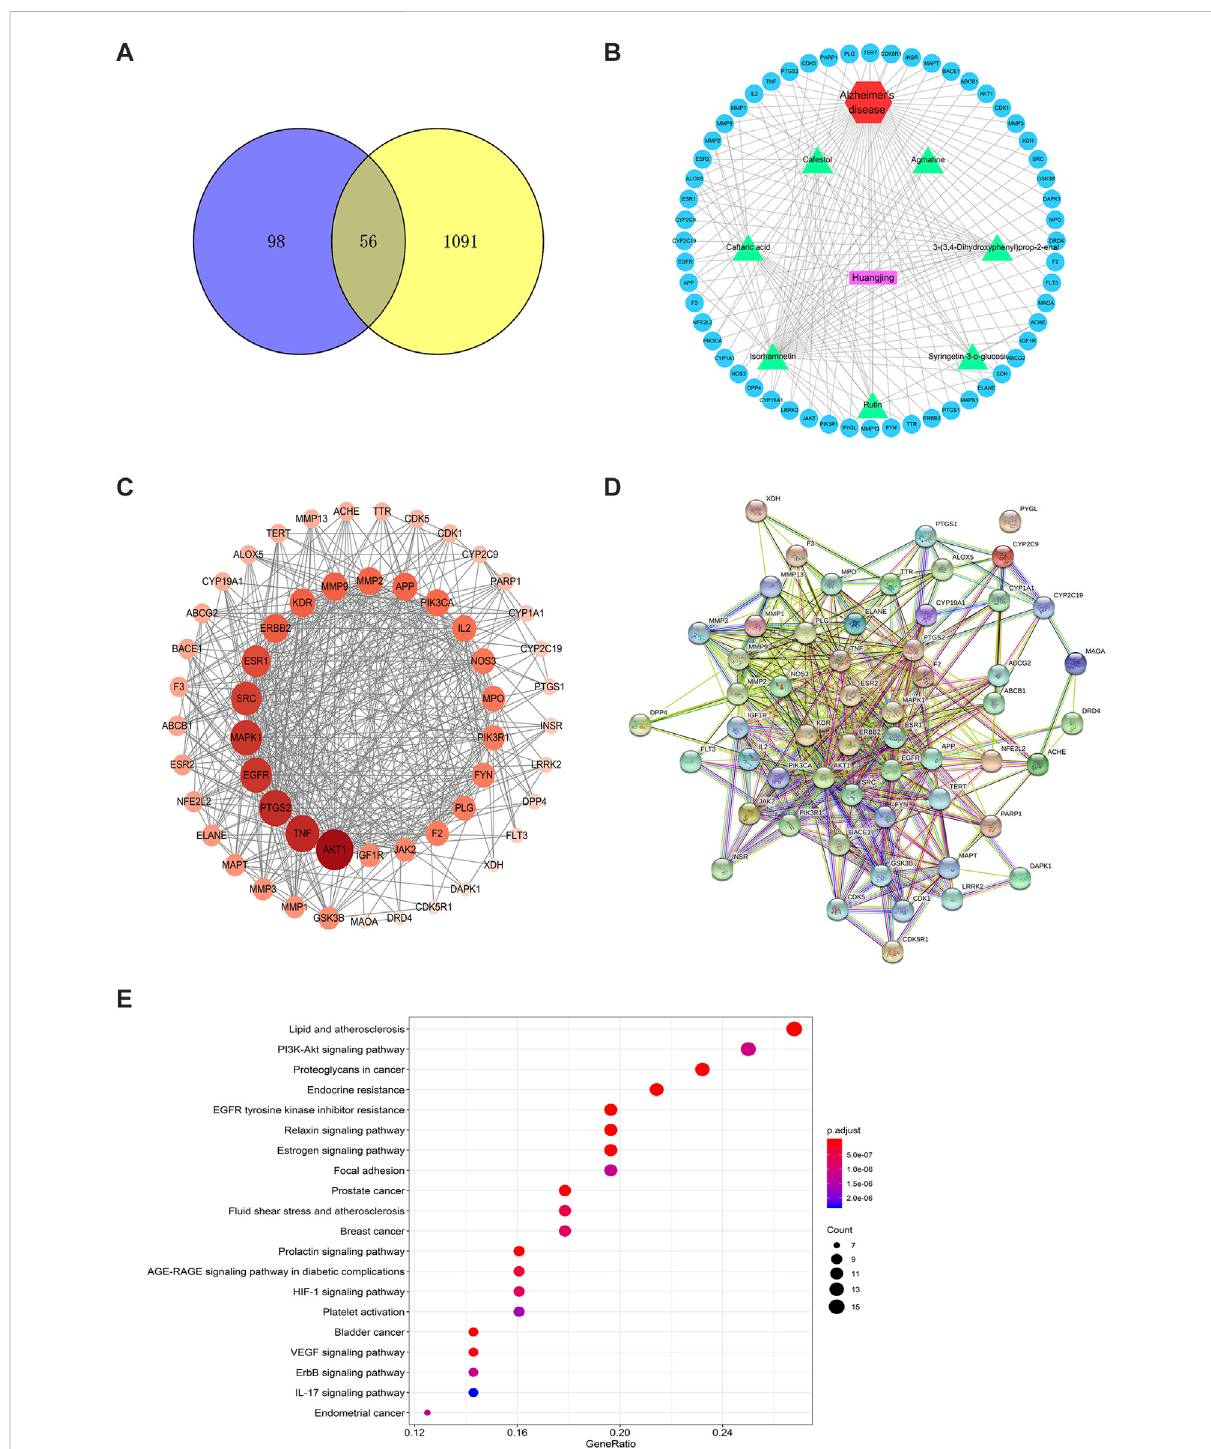
FIGURE 6 The target network of Polygonati rhzoma (Huangjing). (A) Components-targets network; (B) the Venn Diagram between constituents-related targets and Alzheimer ’ s Disease-related targets; (C) The network of 7 constituents and overlapped Alzheimer ’ s Disease-related targets; (D) The PPI network; (E) KEGGanalysisof Polygonatirhzoma .Thesizeandcolorwerecorrelatedtothedegreesoftargetsinnetwork:thebigsizeanddeepcolor with purple means a high degree of this